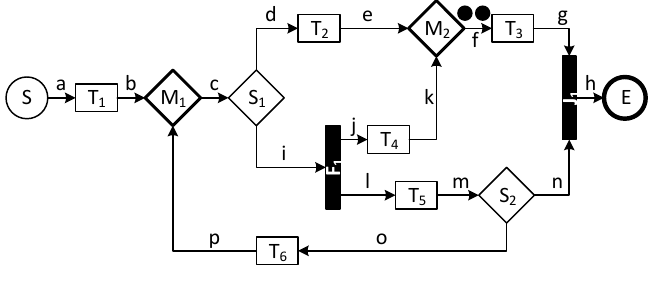
Figure 14. An abundance on the edge